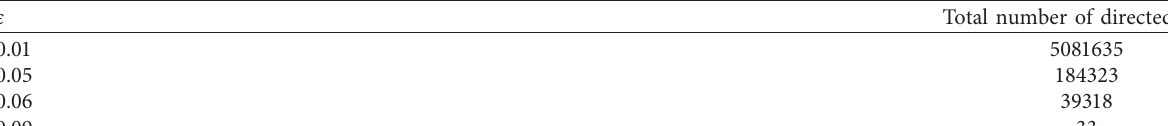
Table 2: Total number of directed edges for traffic causality graph with different ε .